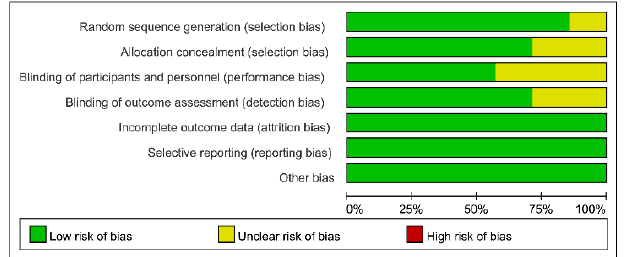
Figure 2. Risks of bias of individual studies.